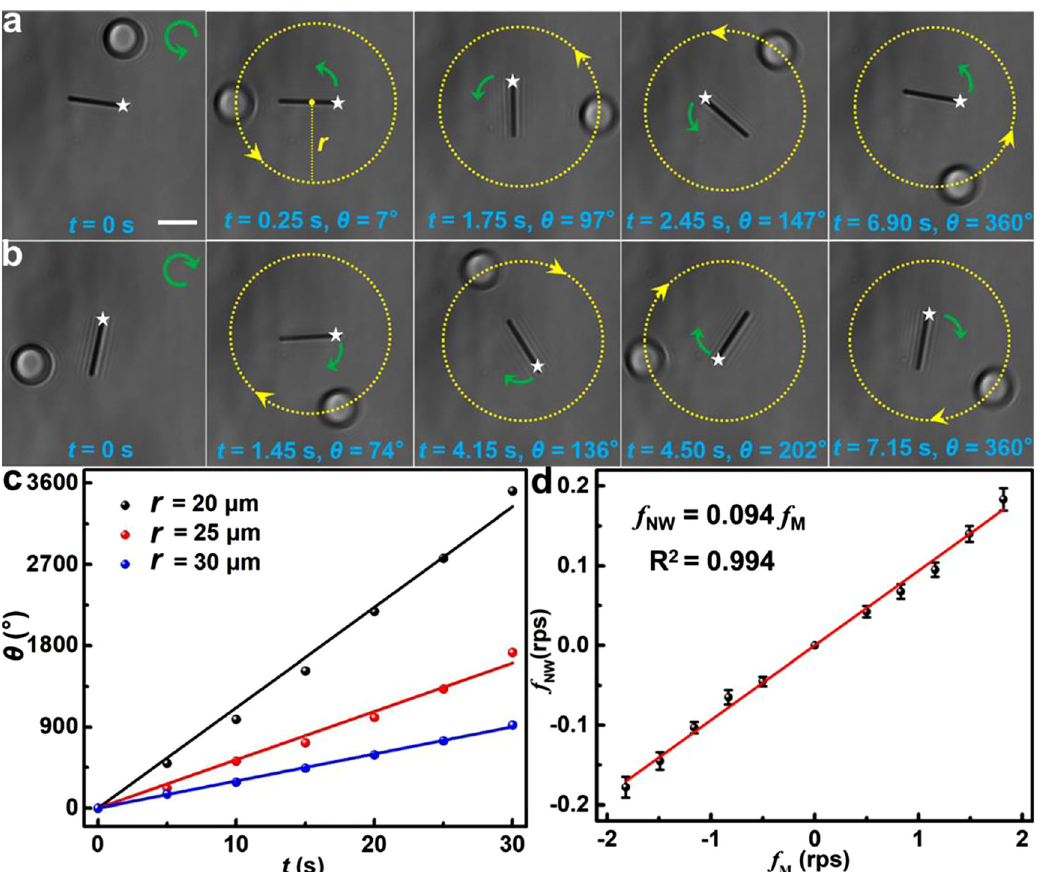
Figure 2: Microsphere-assisted rotation of a single Ag nanowire. Optical images of counterclockwise (a) and clockwise (b) rotation. The scale bar is 10 μ m. (c) The rotation angle of the nanowire at different times with different orbit radius of the microsphere. (d) Rotation speed of the nanowire( f NW )atdifferentrevolutionspeed( f M )ofthemicrosphere.Theorbitradiusofthemicrosphereis25 μ m.Theplusorminusofthevalue represents the counterclockwise and clockwise rotation,